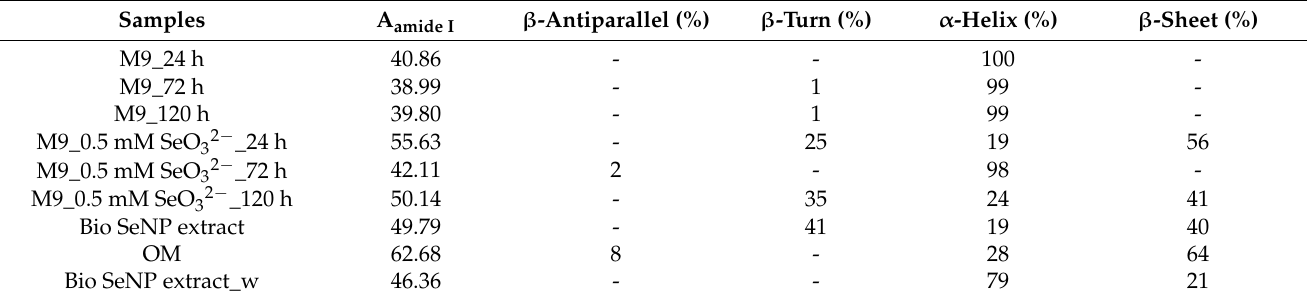
Table 3. Estimation of diverse protein conformations based on amide I component analysis.